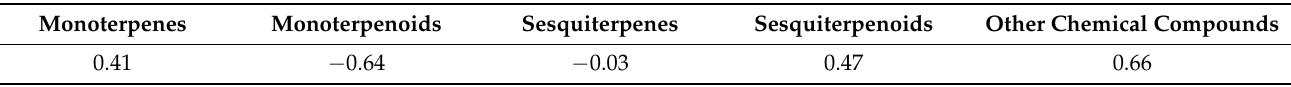
Table 3. Growth rate index correlation matrix against the main groups of compounds in essential oils; the obtained results showed no statistical Figure 7. The clustering of the indexes of linear growth (T) of Fusarium spp. isolates (aggregate